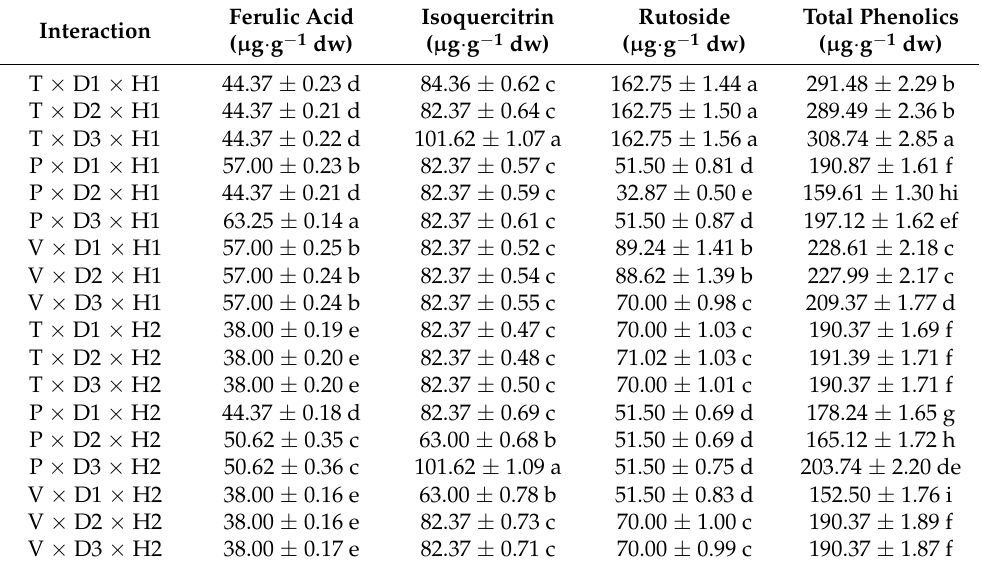
Table 8. Cultivar, plant density and harvesting time interaction effect on phenolic compounds of quinoa leaf